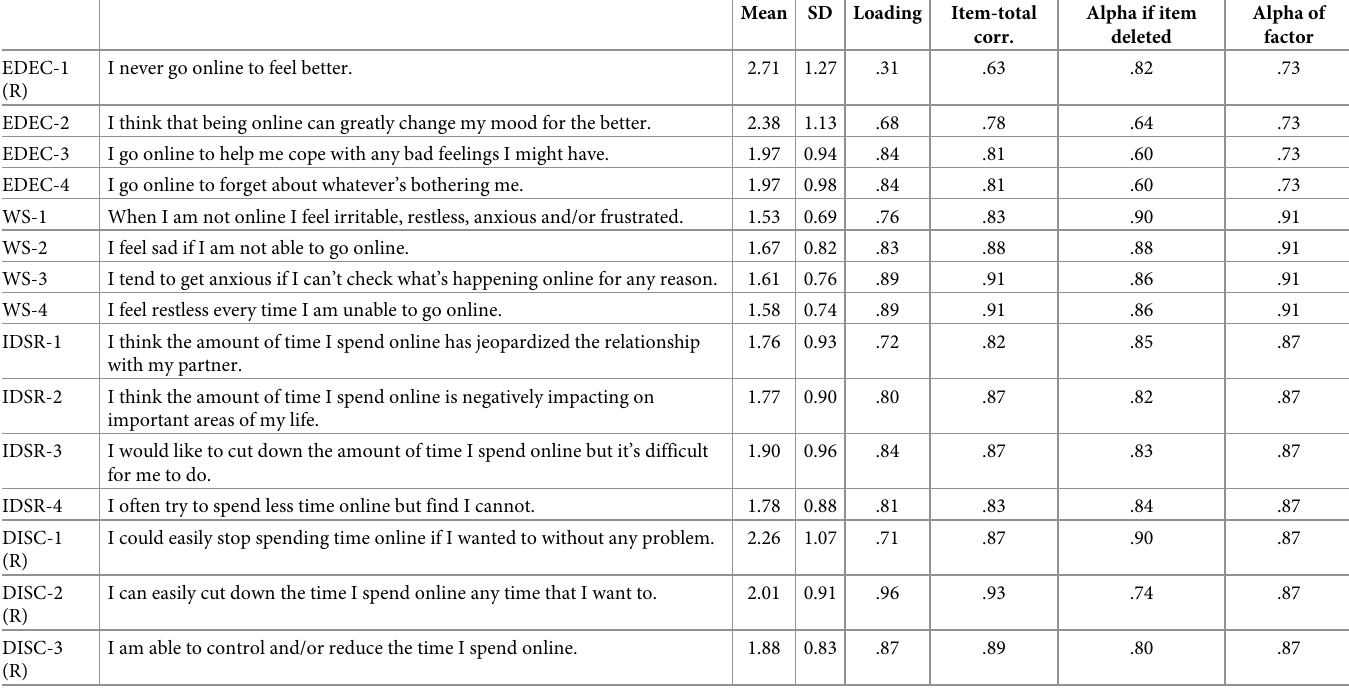
Table 6. Descriptive and psychometric characteristics of IDS-15 at the item